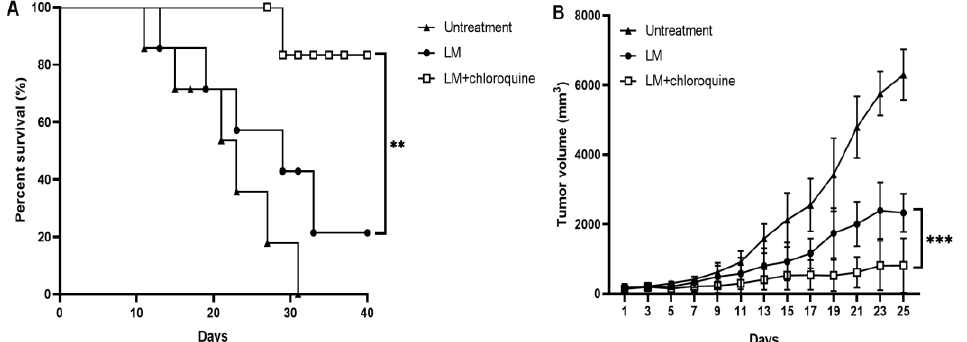
Figure 5. Combined therapy of LM and CQ enhanced cell apoptosis. ( A ) Tumor tissues were excised on day 3 after two intraperitoneal doses and tumor sections were analyzed with an in situ TUNEL assay. TUNEL staining showing apoptosis in mice treated with PBS, LM, or LM + CQ. ( B ) TUNEL- positive cells were counted and the TUNEL index was calculated based on the number of total nuclei and the number of cells with green nuclei in each section. All data are presented as the means ± SD. ** p < 0.01, *** p < 0.001.